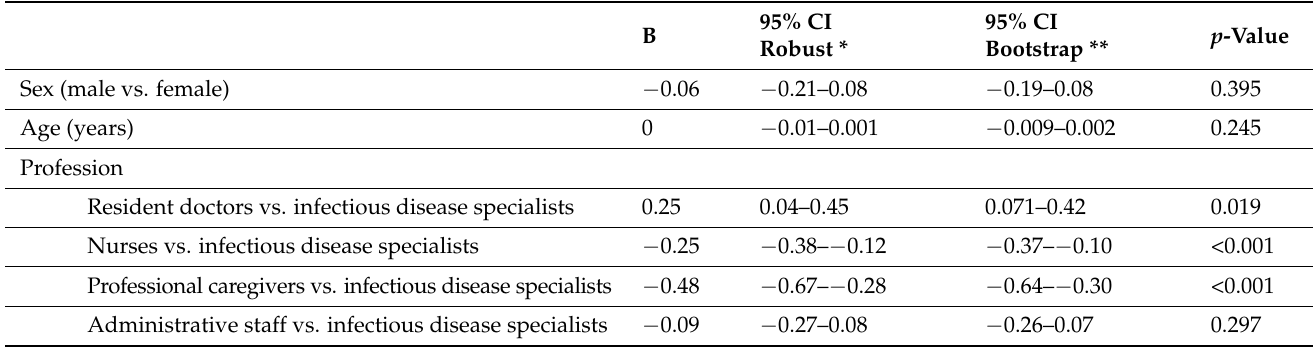
Table 10. Multiple linear regression predicting the natural logarithm of Maslach burnout score based on sex, age, and profession, with robust and bootstrapped bias-corrected and accelerated confidence